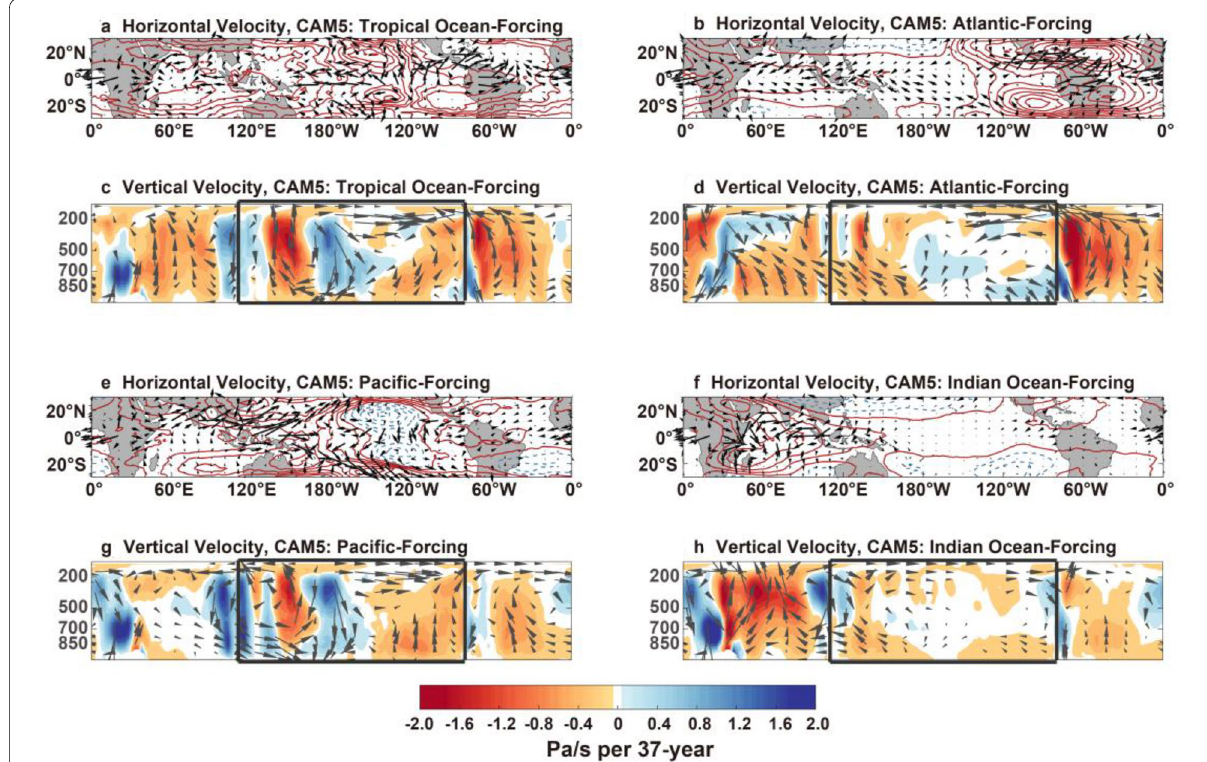
Fig. 5 The horizontal and vertical profiles of the atmospheric circulation responses to the tropical SST forcing in the atmospheric model experiments. a Shows the horizonal profile of the surface wind response (vectors) to the SST forcing in the pan‑tropical‑forcing experiment, with the contours illustrating the 200 hPa geopotential height. c Shows the vertical profile of the same experiment, with vectors representing the zonal and vertical velocity, and the color shading illustrating the intensity of the vertical pressure velocity (omega, red indicates negative values and represents upwelling motion). b , d Show the horizontal and vertical profiles of the circulation responses in the Atlantic‑forcing experiments. e , g Show the horizontal and vertical profiles of the circulation responses in the Pacific‑forcing experiments, and f , h show the horizontal and vertical profiles of the circulation responses in the Indian Ocean‑forcing